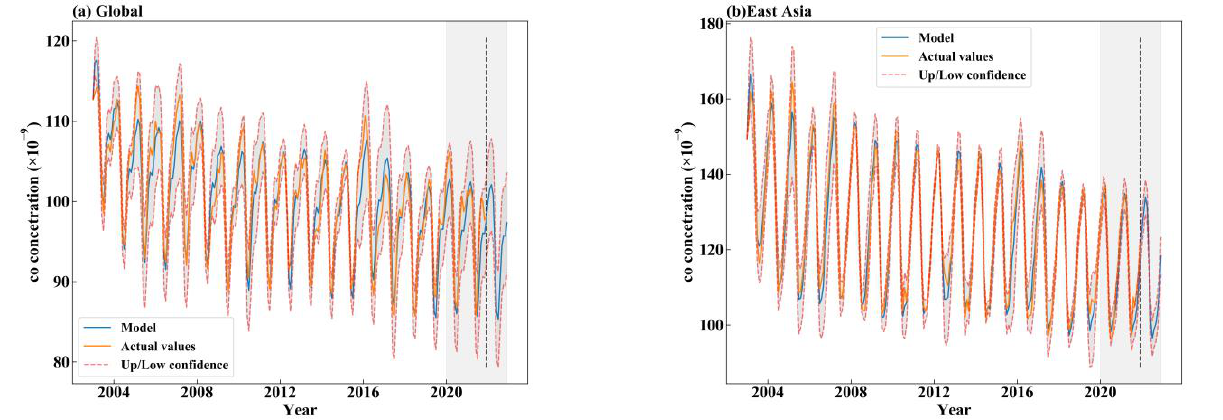
Figure 14. Prediction chart of CO time series in the near surface region of the world and East Asia. ( a ) Global; ( b ) East Asia. Table 5. Evaluation index of global and East Asian near surface CO data sets under three-exponential smoothing model. Area MAE RMSE R 2 Global 1.469